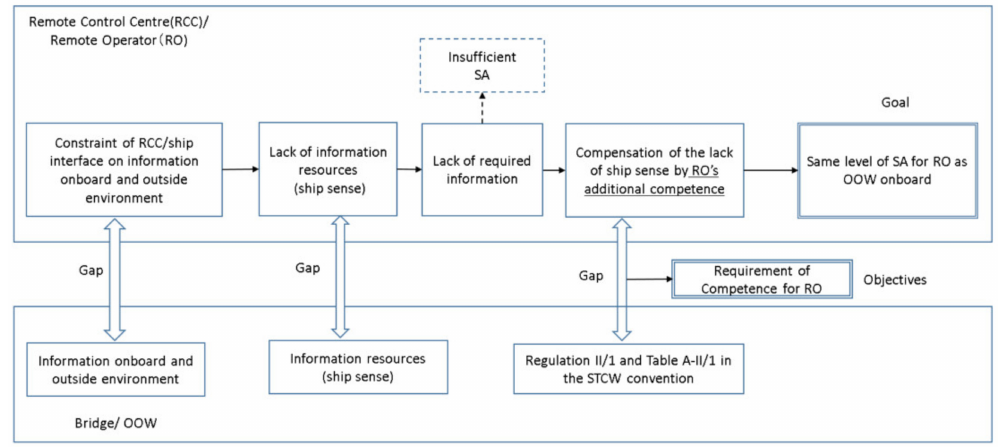
Figure 2. Scheme of goal-based gap